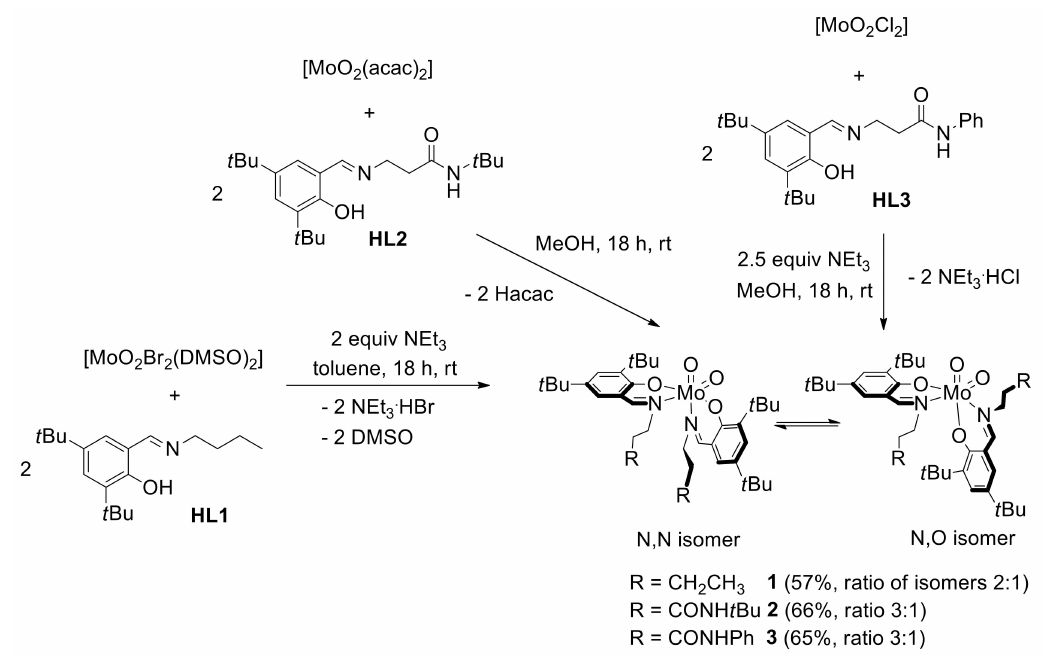
Scheme 2. Synthesis of complexes 1 – 3